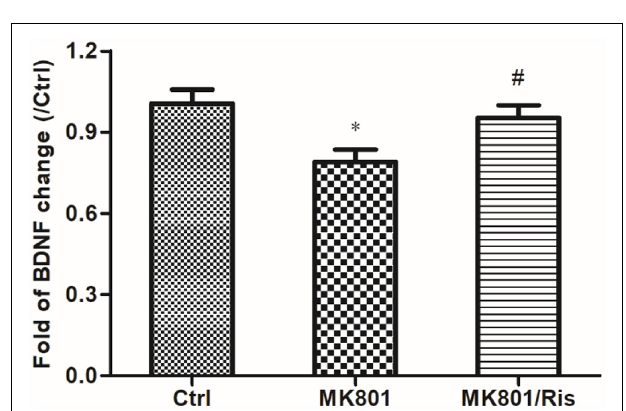
FIGURE 5 | Risperidone reverses the downregulation of BDNF in the hippocampus of rats treated with MK801. Rats were administered MK-801 (0.5 mg/kg body weight, i.p.) once daily for 6 days. Subsequently, rats in the MK-801+ risperidone group were injected with risperidone (1 mg/kg body weight, i.p.) once daily for 7 days, whereas those in the MK-801 group received an equal volume of normal saline. Control group received an equal volume of normal saline once daily for 13 days. BDNF expression in hippocampal lysates was detected by real-time PCR ( n = 4 per group). Densitometric values are expressed as mean ± SEM. ∗ P < 0.05 vs. control group; # P < 0.05 vs. MK801 group.